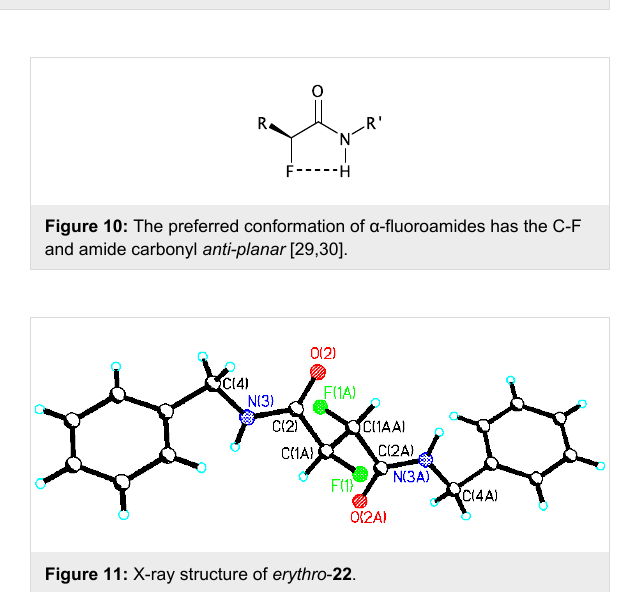
Figure 8: Newman projections showing the staggered conformations of erythro - and threo - 21 .